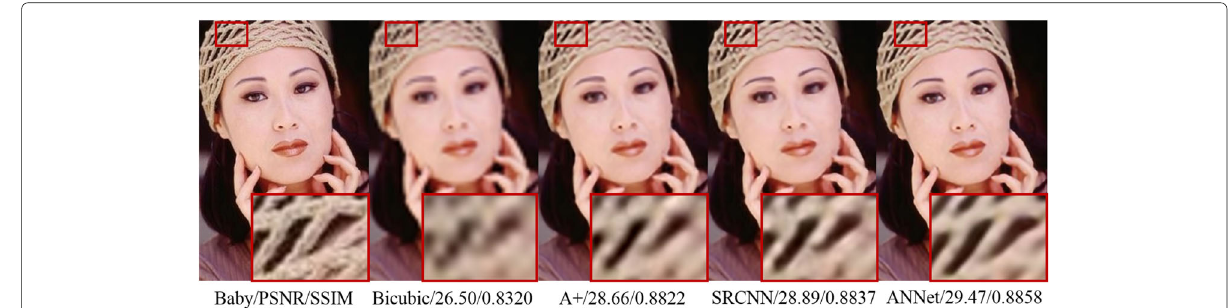
Fig. 6 Visual quality comparison of single image SR on image woman from Set5 [1] with upscaling factor